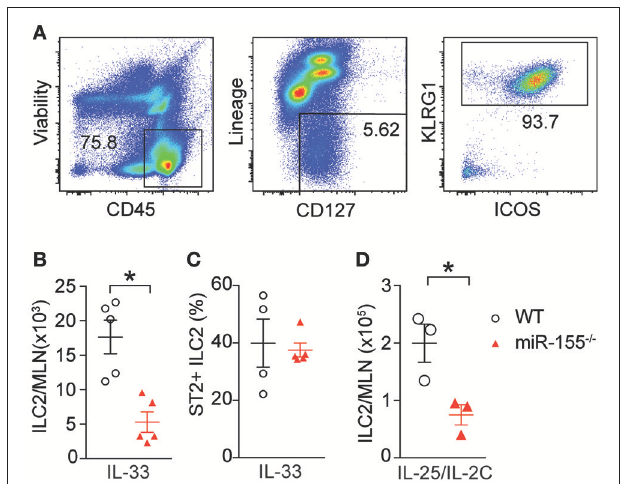
FIGURE 2 | miR-155 is required for ILC2 expansion in response to IL-25 and IL-33. WT and miR155 − / − mice were treated with intra-peritoneal (i.p.) IL-33 (A–C) or IL-2/anti-IL-2/IL-25 complex (D) , for 3 days. (A) Representative staining of ILC2 (CD45 + Lin − ICOS + KLRG1 + ) isolated from mesenteric lymph node (MLN). (B) Quantification of ILC2 in MLN. (C) Percentage ST2 + WT and miR155 − / − ILC2. (D) Quantification of ILC2 following IL-2/anti-IL-2/IL-25 (IL-25/IL-2C) complex treatment. Data (A,B,D) are representative of three independent experiments; (C) a single experiment. * p ≤ 0.05 with Student’s t-